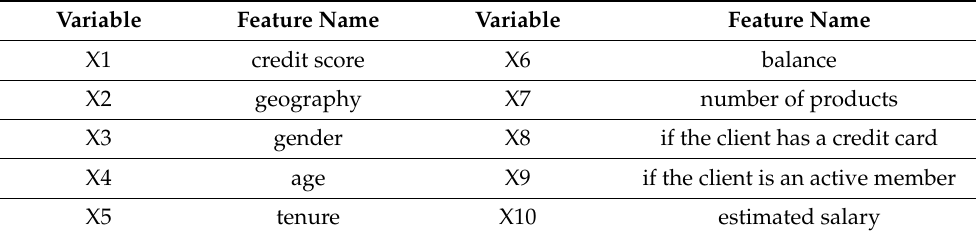
Table 2. Variables on x-axis and their corresponding feature names for dataset 1.